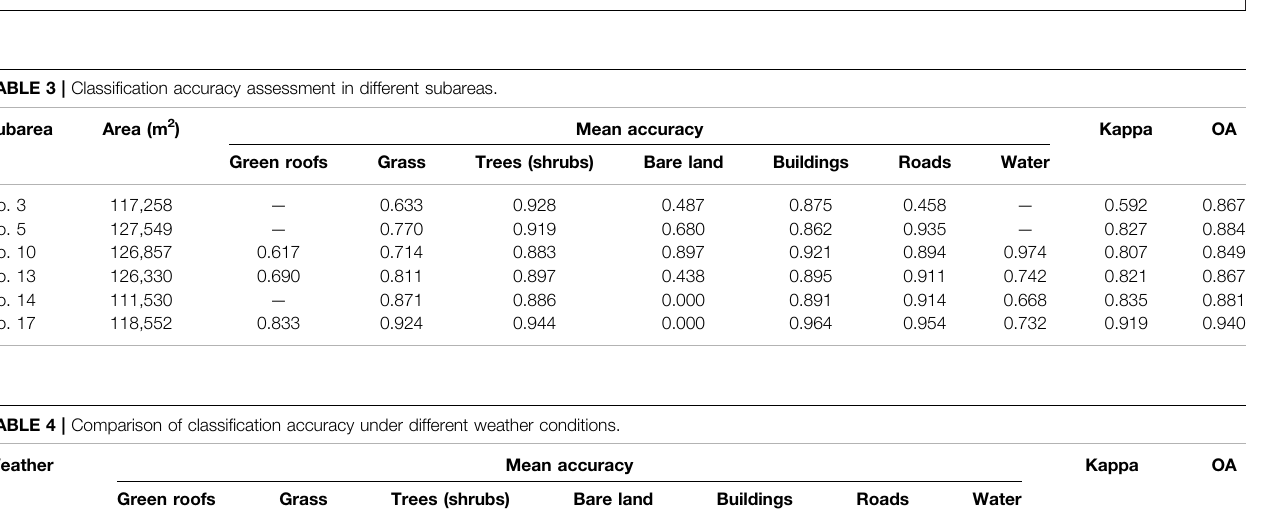
FIGURE 6 | Classi fi cation results in subareas of the study area, and the kappa coef fi cients and OAs.